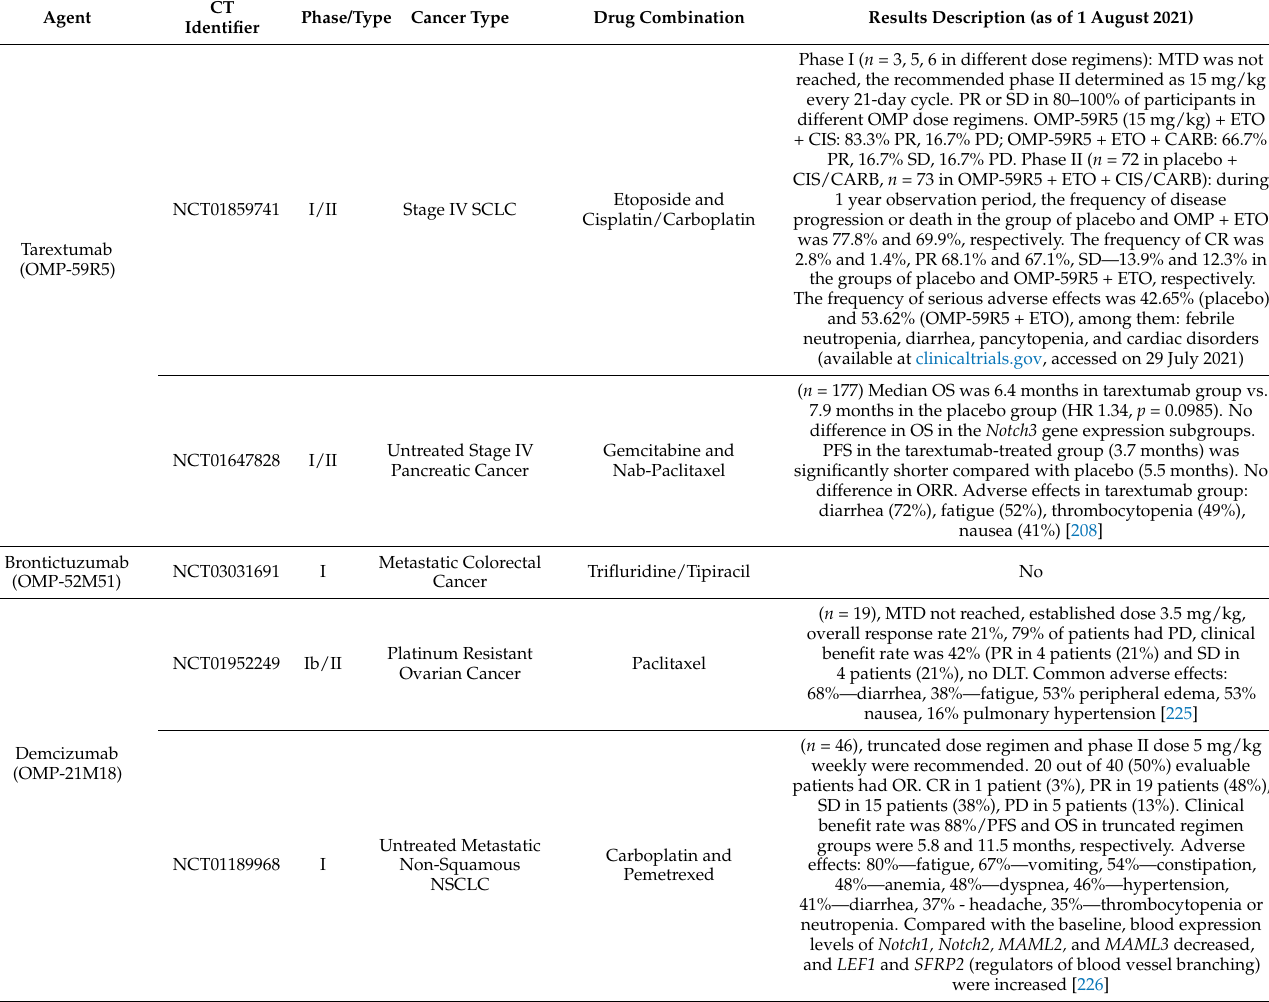
Table 2. Clinical trials with monoclonal antibodies against Notch receptors and ligands in combination with chemothera- peutic drugs registered at